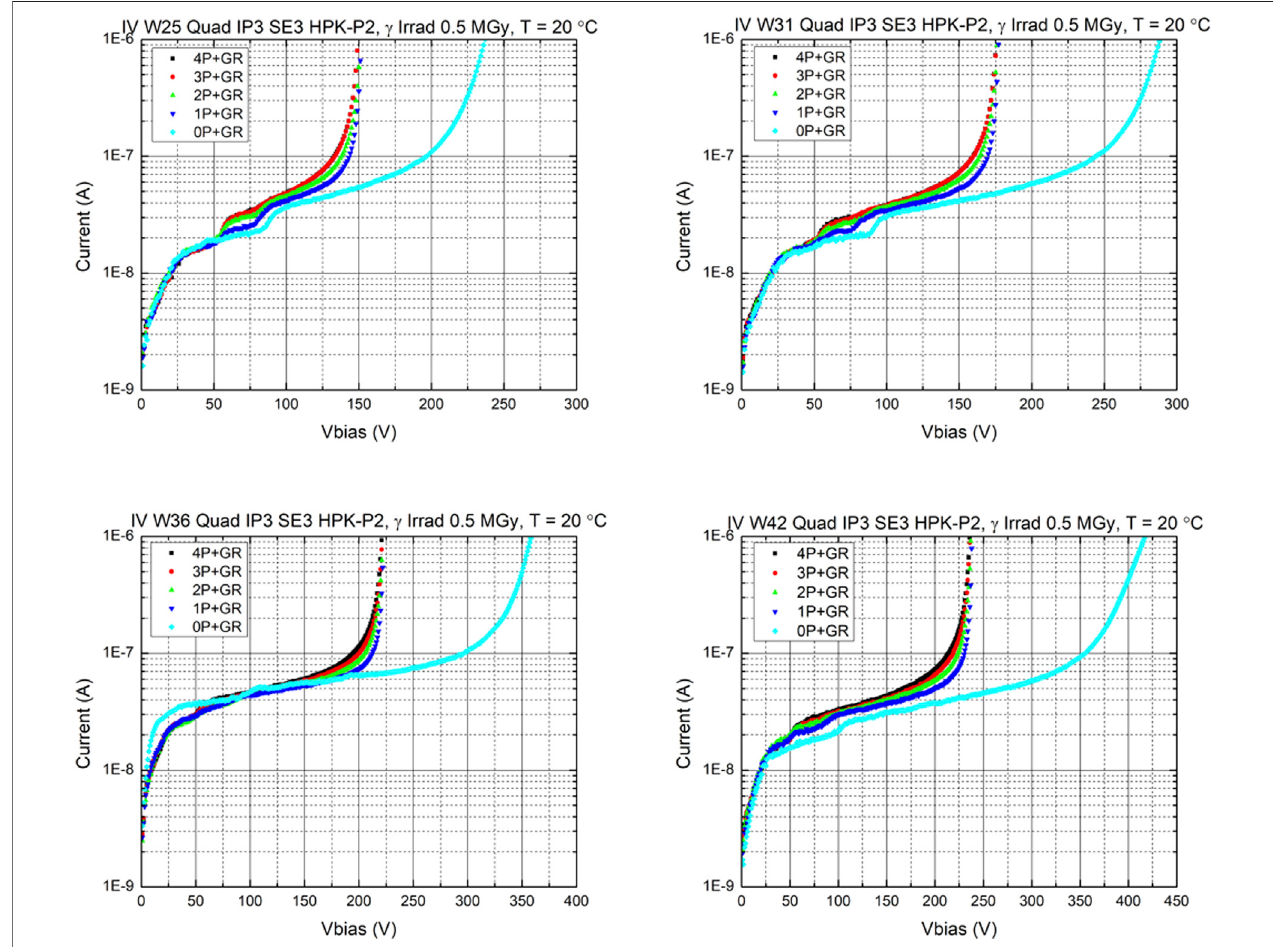
FIGURE 9 | Leakage current versus applied bias voltage, for quad devices taken from all wafers (thus with four different initial values of the gain layer depletion voltage).Thesemeasurementsweremadeatroomtemperatureafterapplicationof0.5 MGy,forthemeasurementcon fi gurationinwhichbiasisappliedtothebackside of the chip, and leakage current is measured with ground connected to the guard ring plus 0, 1, 2, 3, or all 4 pads.